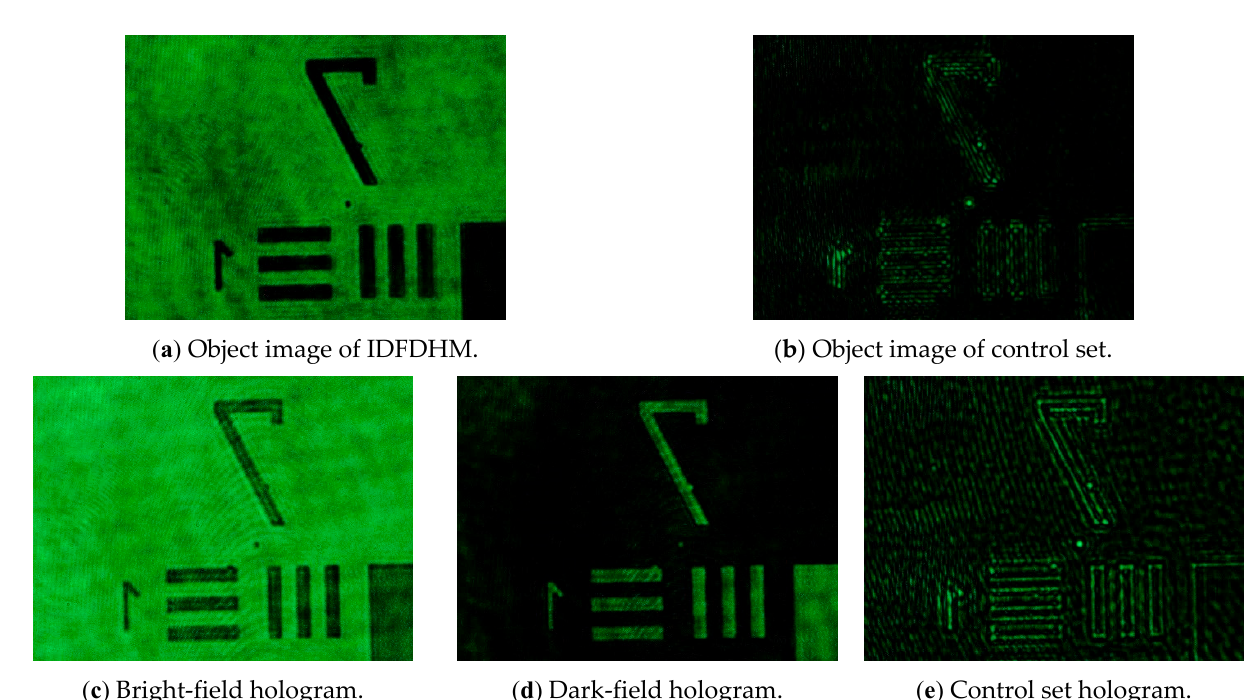
( c ) Bright-field hologram. ( d ) Dark-field hologram. ( e ) Control set hologram. Figure 3. Captured object images under ( a ) IDFDHM and ( b ) control set; ( c – e ) are the captured hologram images. Image enhancement was applied to all images: brightness +20%.